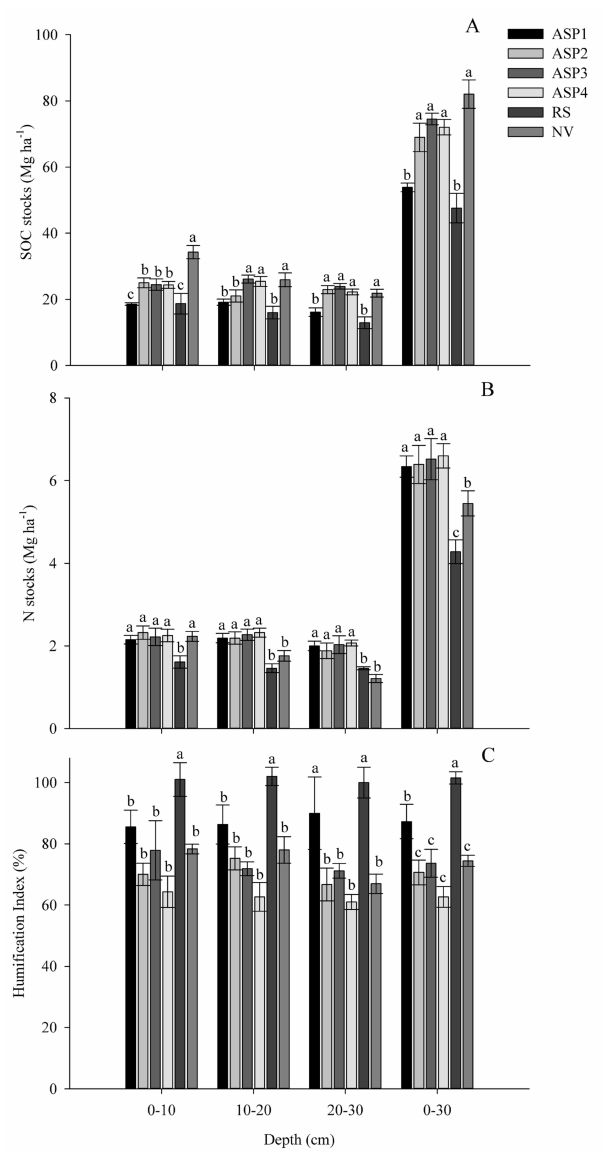
Figure 3. Soil organic C (SOC) ( A ) and N ( B ) stocks and humification index ( C ) under different land use and management systems at Bonsucesso farm in Minas Gerais State, Brazil. Systems: E. camaldulensis × E. tereticornis hybrid intercropped with buffel grass using the arrangements 2 × 3 + 10 m (ASP1) and 2 × 3 + 15 m (ASP2); E. urophylla × E. grandis hybrid intercropped with buffel grass using the arrangements 2 × 3 + 10 m (ASP3) and 2 × 3 + 15 m (ASP4); Regeneration stratum (RS); and native vegetation (NV). Means followed by the same letter for each soil depth layer did not differ in the Scott-Knott test ( p < 0.05). Error bars indicate the standard error of the